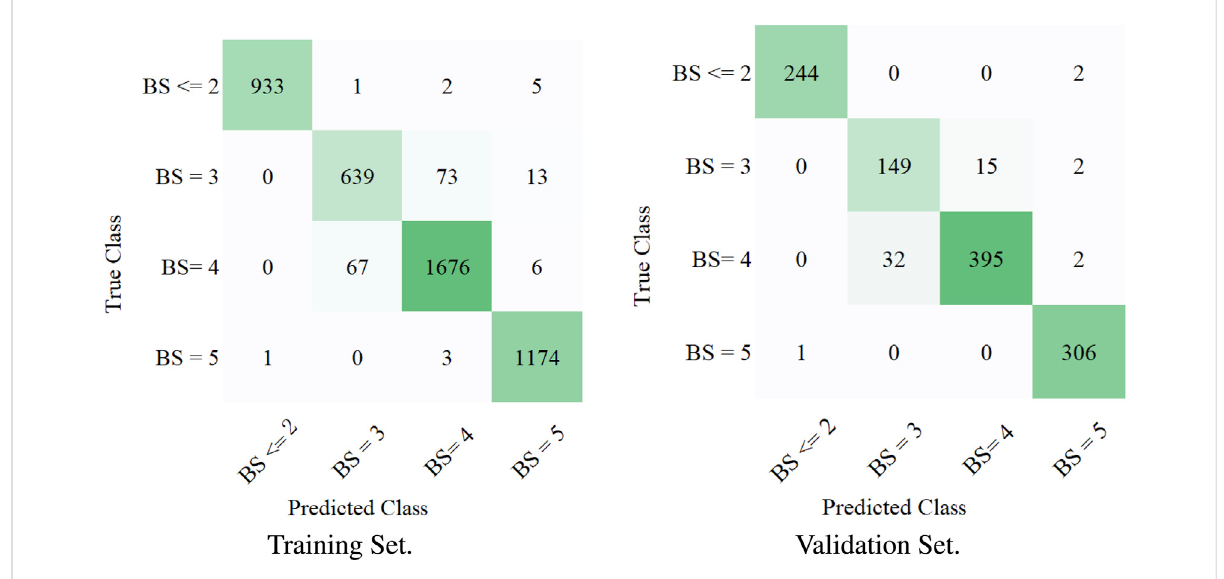
FIGURE 3 Confusion matrix for the training set and validation set. BS represents the BASED